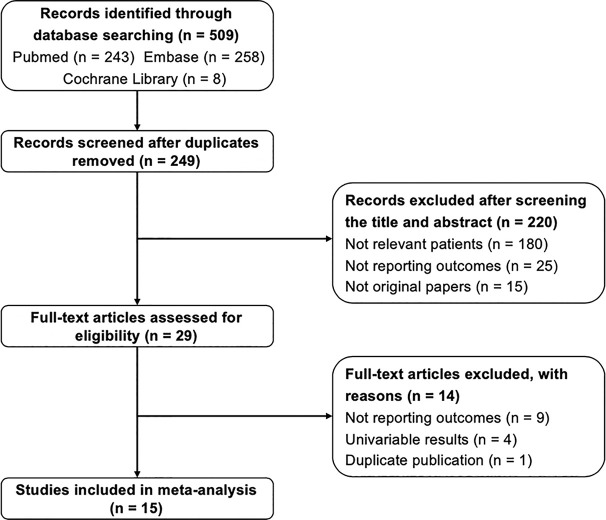
Flow chart of literature search and selection process.